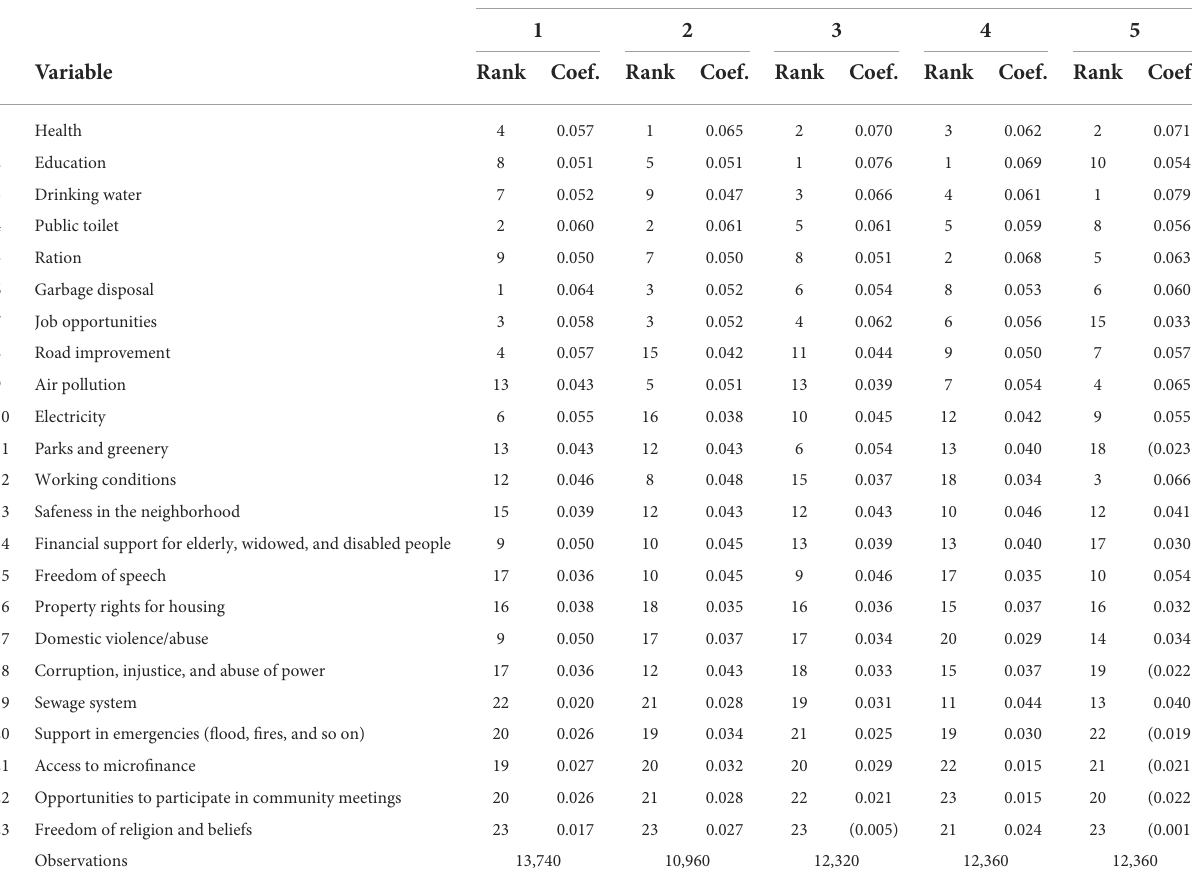
TABLE 8 Marginal utility estimates by asset